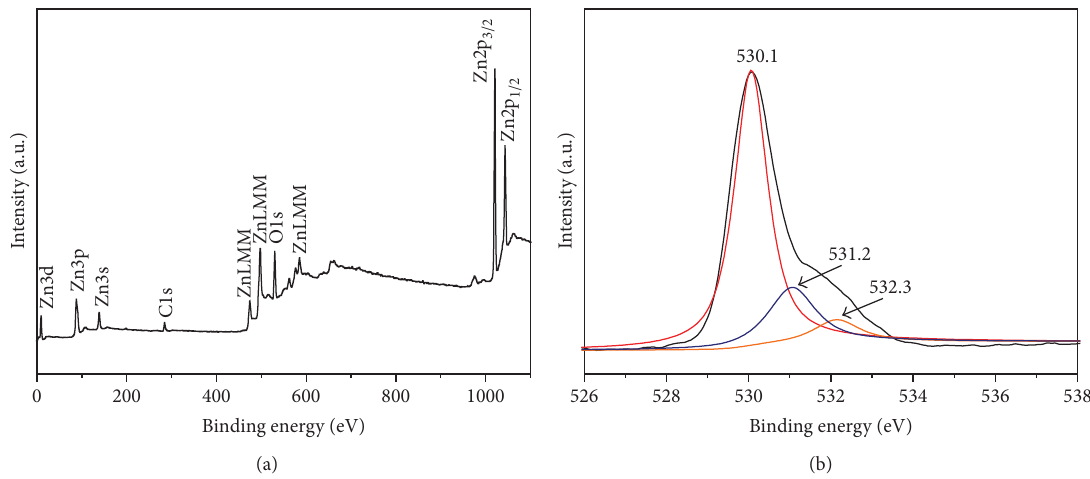
Figure 3: XPS spectra of the snowflake-shaped ZnO nanostructures: (a) survey spectrum and (b) O 1s spectrum.